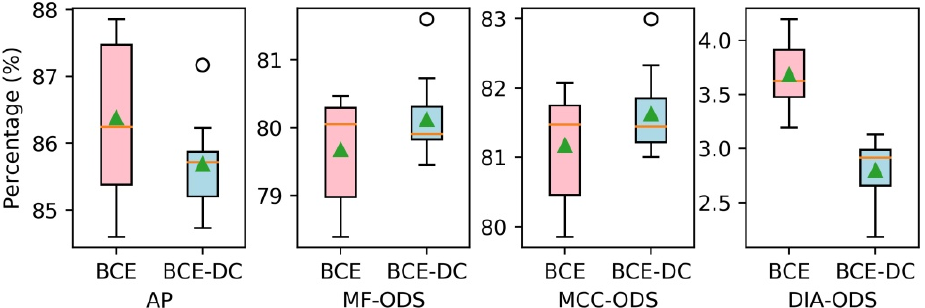
Figure 10. The BCE loss and DC loss of the training processes for FCN models trained with differ- ent losses.